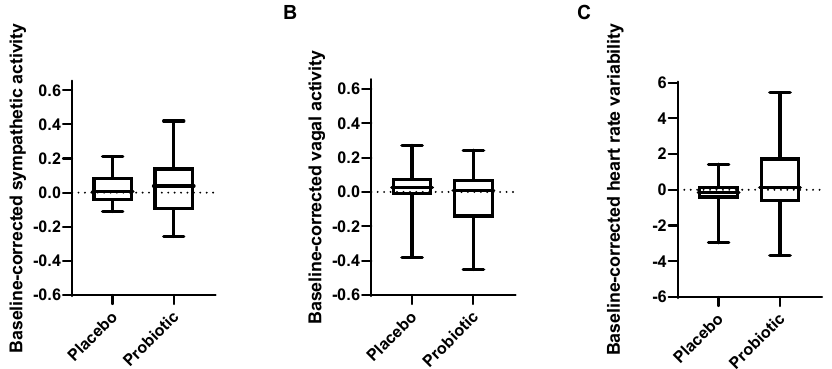
Figure 2. Effect of probiotic intervention on autonomic nervous system function. Baseline-corrected ( A ) sympathetic activity, ( B ) vagal activity, ( C ) heart rate variability. Line presents median, box presents 25th and 75th percentile, whiskers present minimum and maximum.